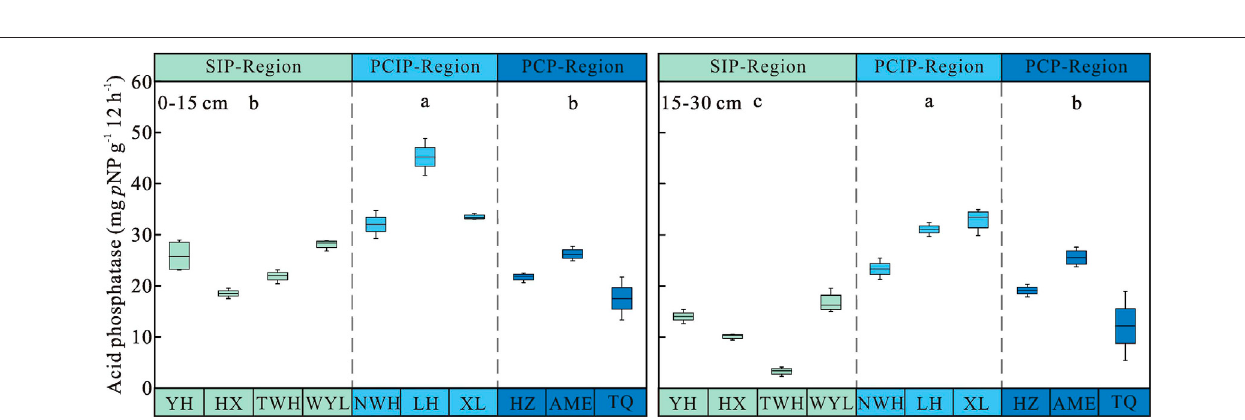
FIGURE 5 | Soil acid phosphatase activity in peatlands from different types of permafrost